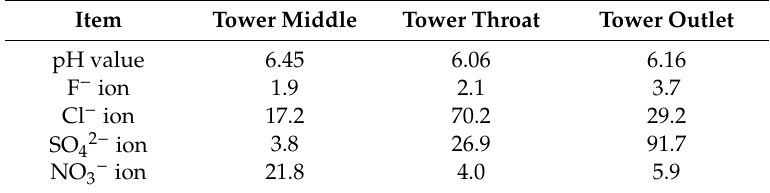
Table 4. Average pH values and anion contents in the condensate at different locations (mg/L).